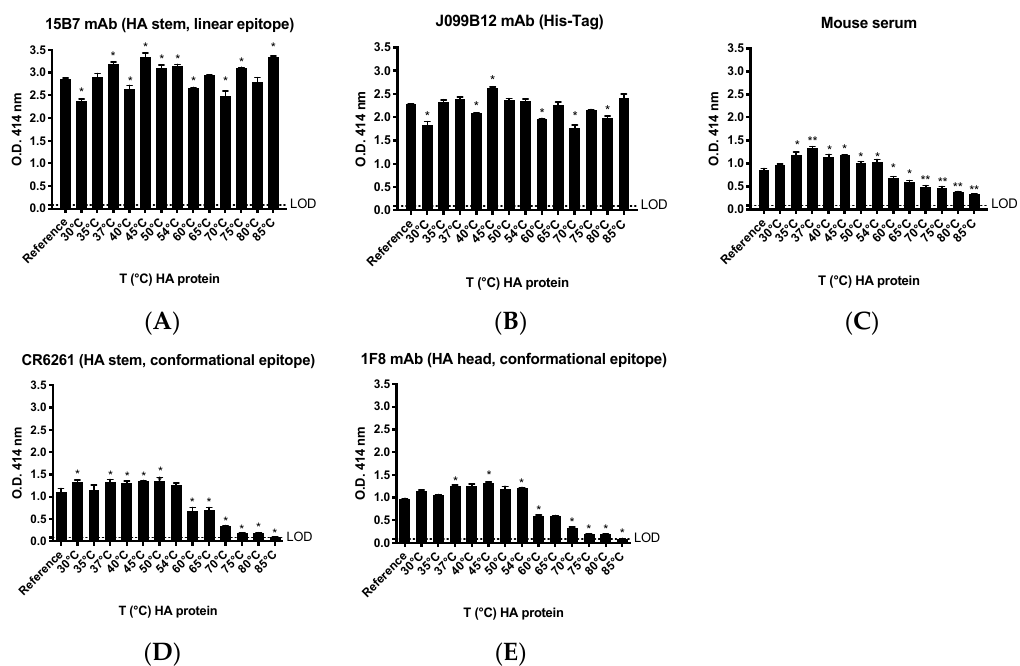
Figure 7. Thermal stability of stably-transfected cell line-derived purified rHA (from CA/09) following treatment at different incubation temperatures. After temperature treatments, the following was assessed: ( A , B ) binding of mAbs 15B7 (HA linear epitope) and J099B12 (His-Tag); ( C ) mouse CA/09-specific polyclonal serum; and ( D , E ) conformation-sensitive directed mAbs (CR6261 and 1F8). LOD represents the limit of detection. Asterisk on the top of bars indicates a statistically significant OD414 difference as compared to the reference protein (* p < 0.05; ** p < 0.01).